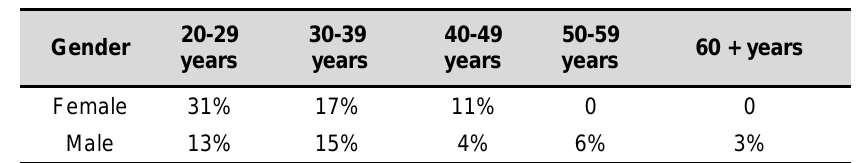
Table 1 - The gender of employees in archaeology by age